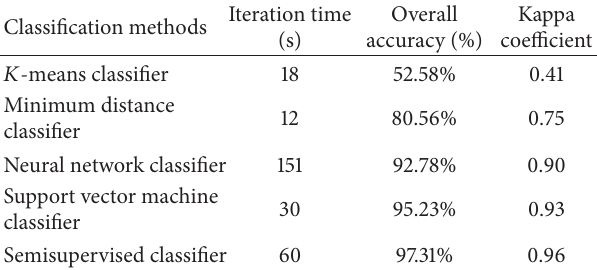
Table 2: Overall accuracy and Kappa coefficient based on compar- ison of the varying classification